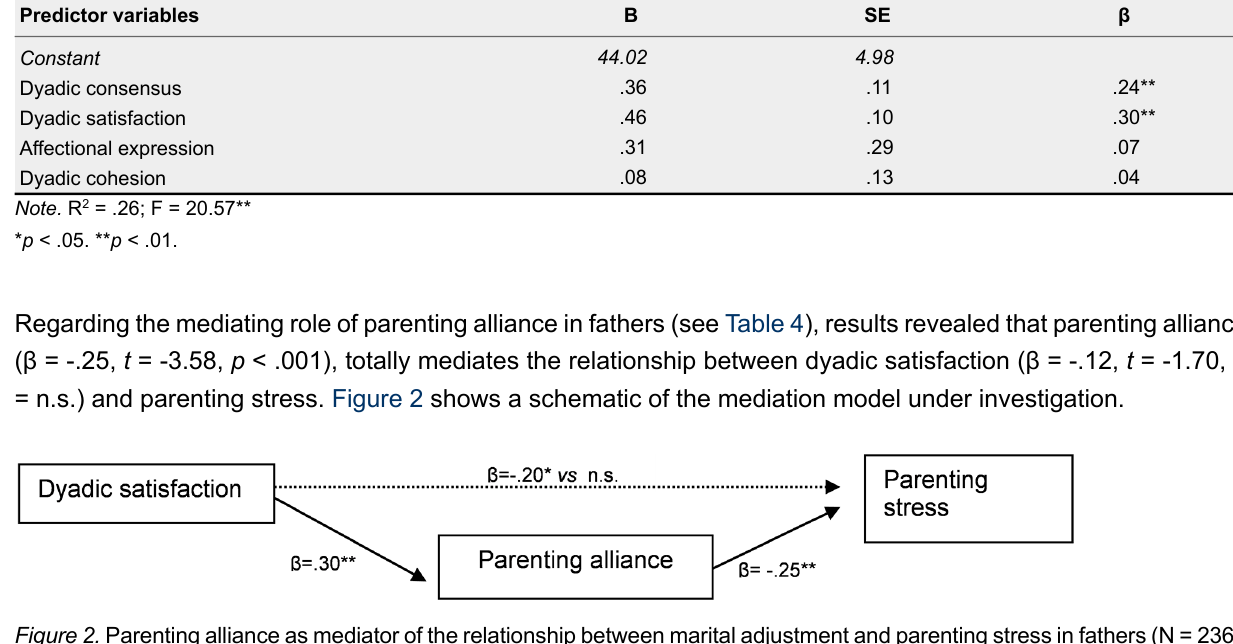
Figure 2. Parenting alliance as mediator of the relationship between marital adjustment and parenting stress in fathers (N =